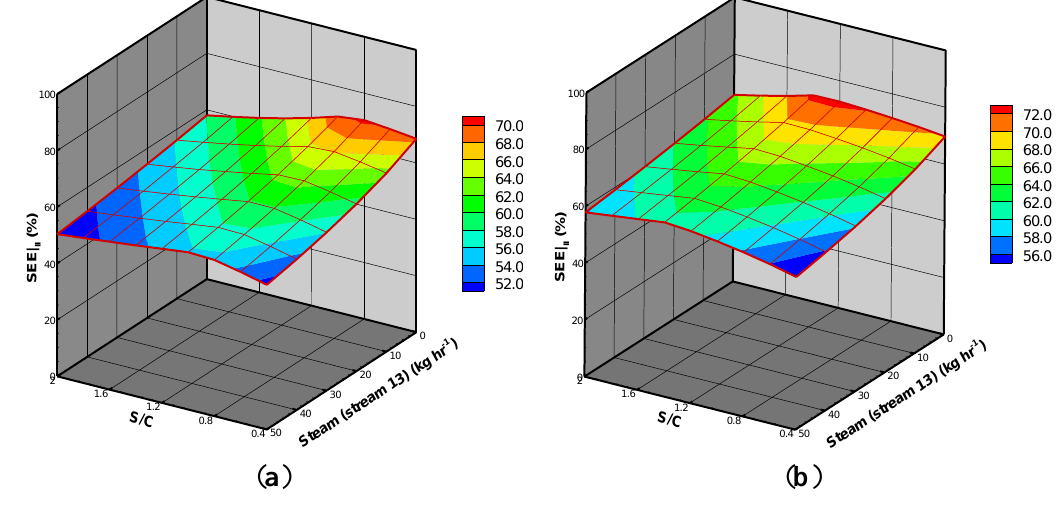
Figure 8. Three-dimensional distributions of system energetic efficiency from the gasification of ( a ) ROP; and ( b ) TOP.